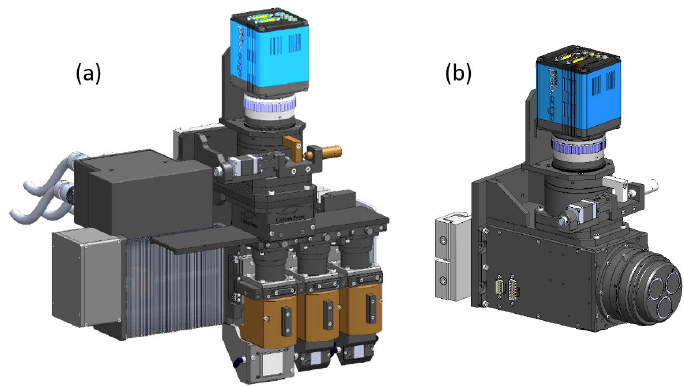
Figure 4. ( a ). White-beam detector with three objective lenses. ( b ). Monochromatic-beam detector with three objective lenses.